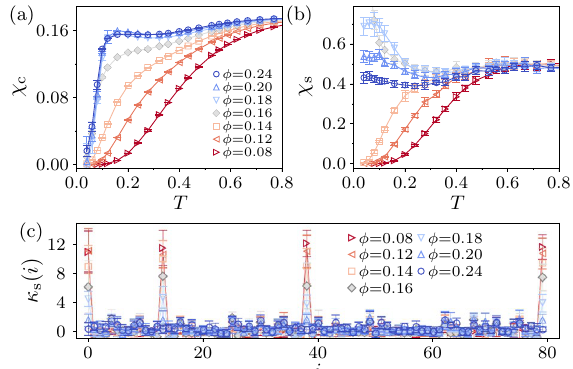
Figure 4. Temperature dependence of ( a ) charge compressibility χ c and ( b ) spin susceptibility χ s for the system of L = 5 under the PBC at U = 3 . ( c ) Site-resolved spin susceptibility κ s ( i ) for L = 4 under the OBC at U = 3 and T = 0.08 . The critical point estimated by the value of (cid:31) S